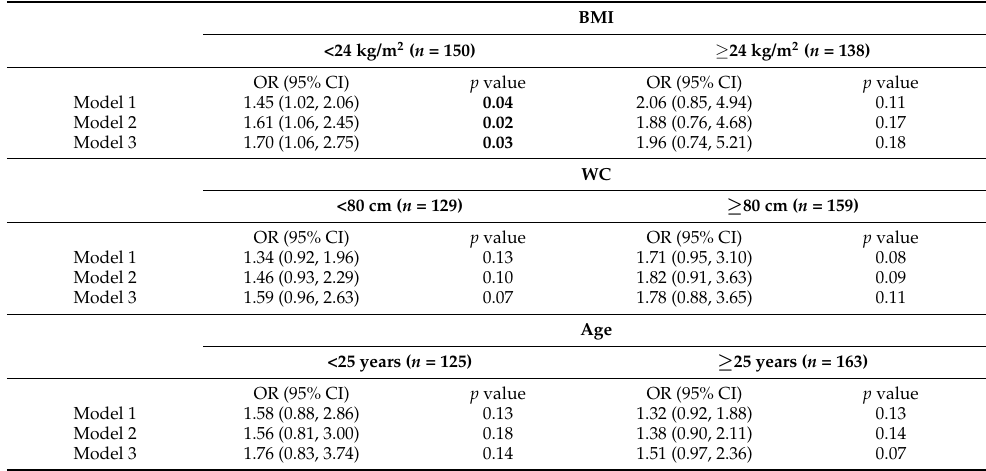
Model 1: Adjusted for Age, BMI, WC. Model 2: Adjusted for Age, BMI, WC, hs-CRP, UA, TG, HDL-c, LDL-c and HOMA-IR. Model 3: Adjusted for Age, BMI, WC, hs-CRP, UA, TG, HDL-c, LDL-c, HOMA-IR, LH, FSH, E2 and FAI. Significant p -values ( p < 0.05) are highlighted in